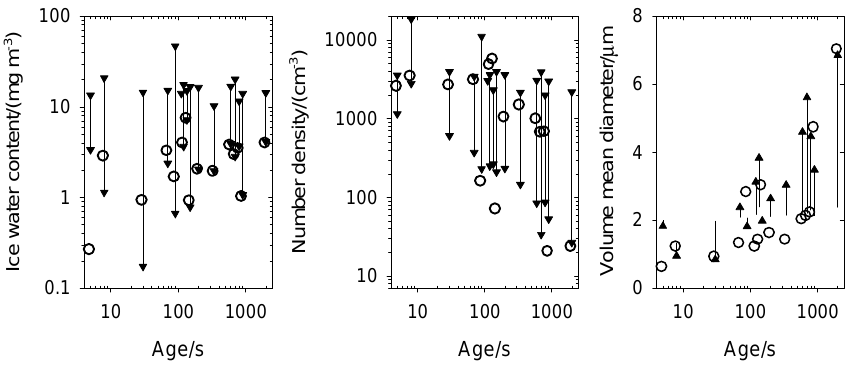
Fig. 17. Comparison of CoCiP results (lines with triangles, pointing towards increasing shear in the range 0– 0.002s − 1 ), with observations (open circles) versus contrail age. From left to right: Ice water content, ice particle number concentration, volume mean ice particle